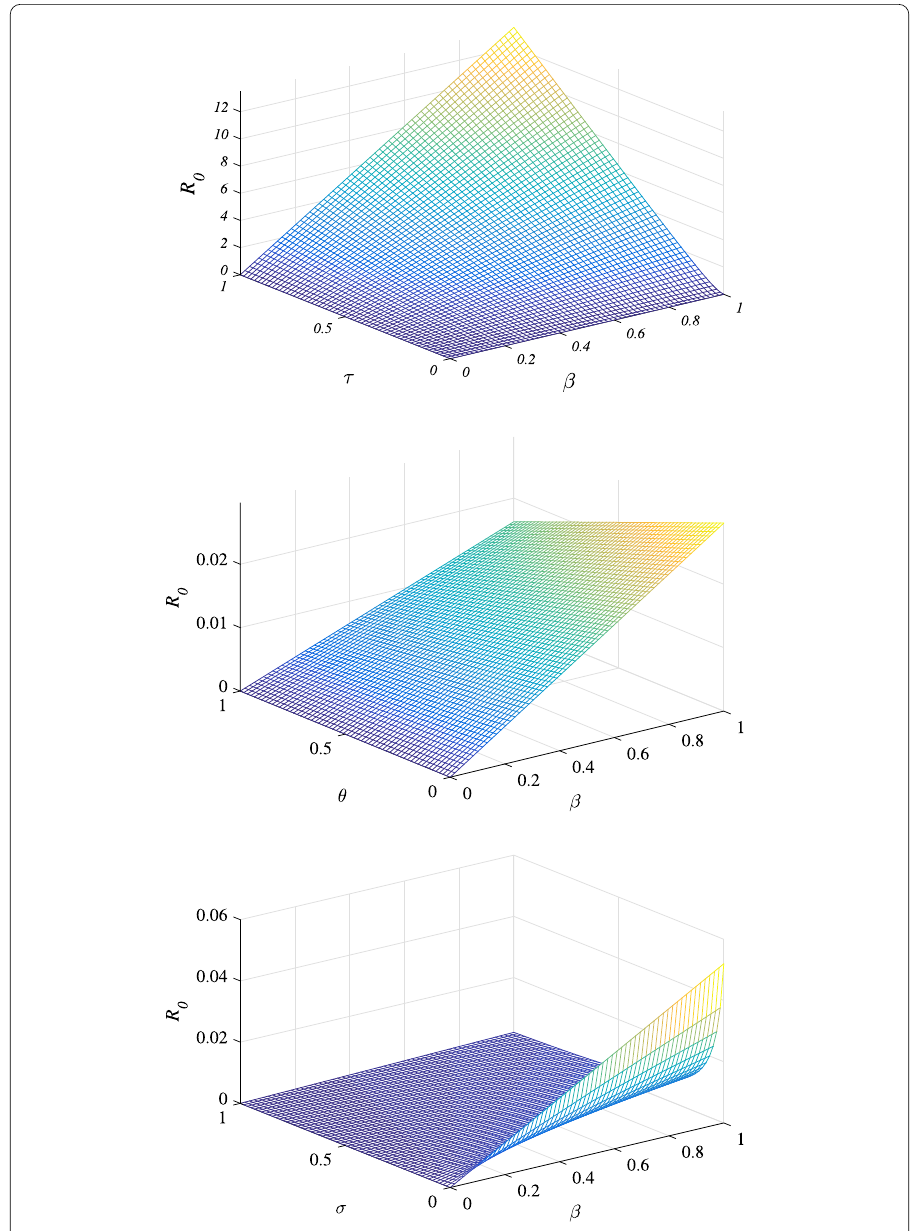
Figure 1 Three-dimensional plot of the basic reproduction number versus different parameters involved in the model under consideration. The parametric values are given in Table 1 at the end